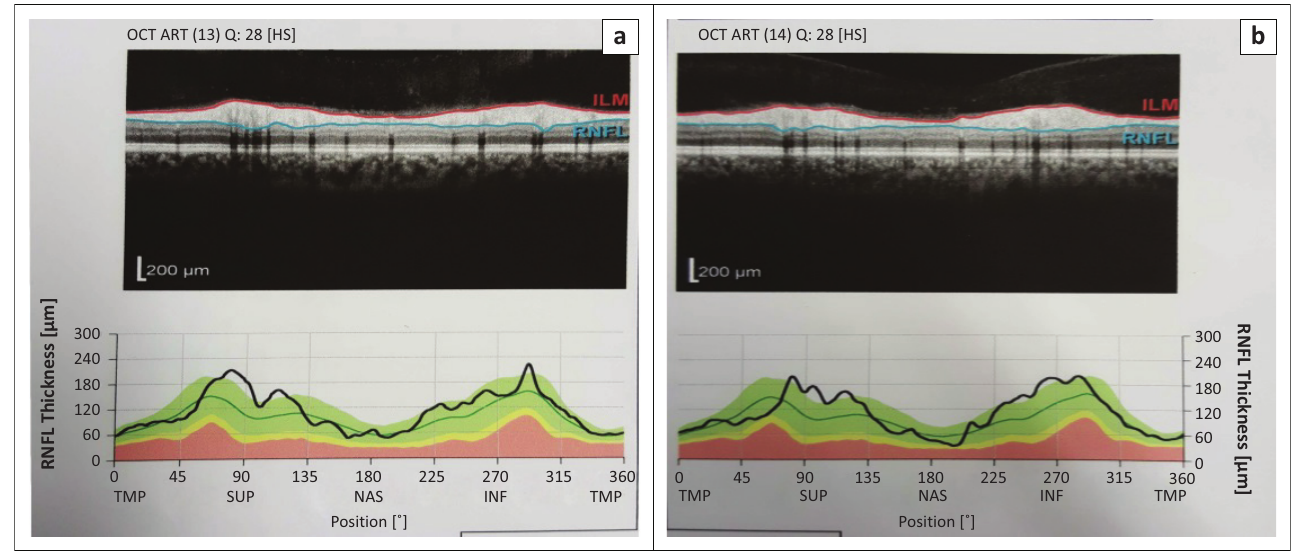
FIGURE 3: Optical coherence tomography scan showing the retinal nerve fibre layer thickness of the (a) right eye and (b) left eye with no abnormalities.